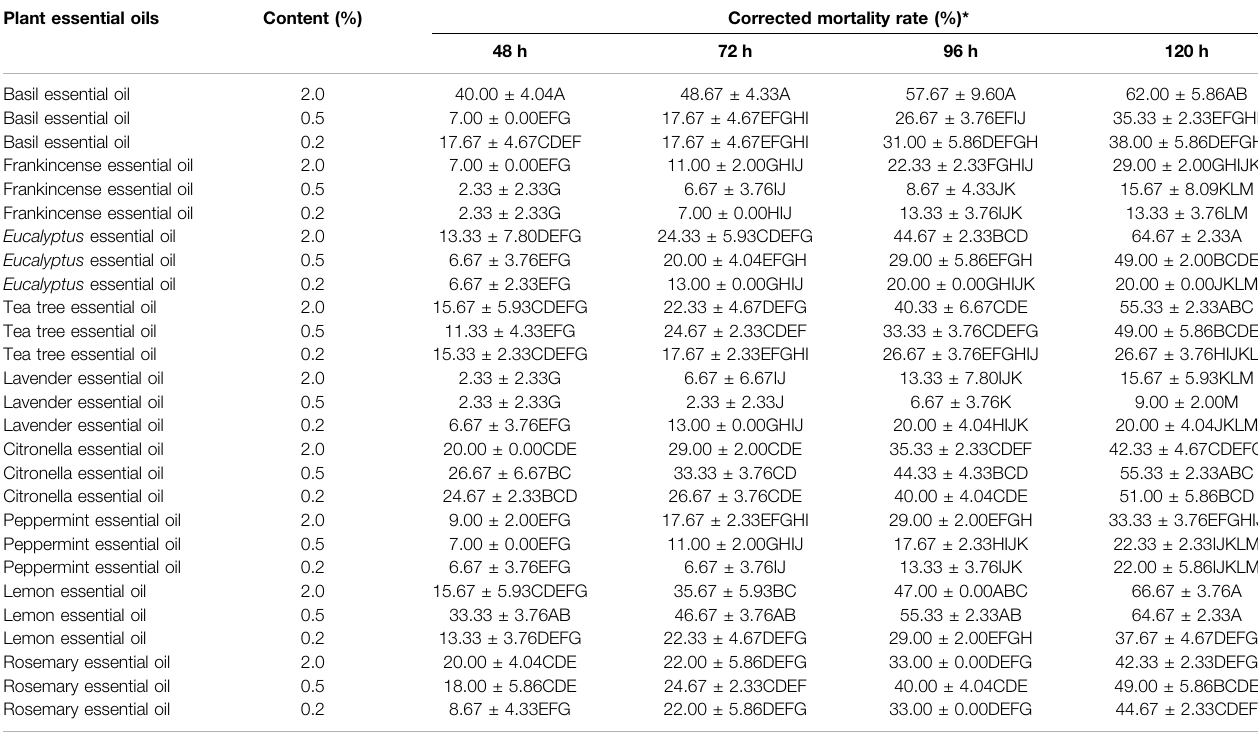
TABLE 3 | The contact activity of plant essential oils against armyworms larvae. Plant essential